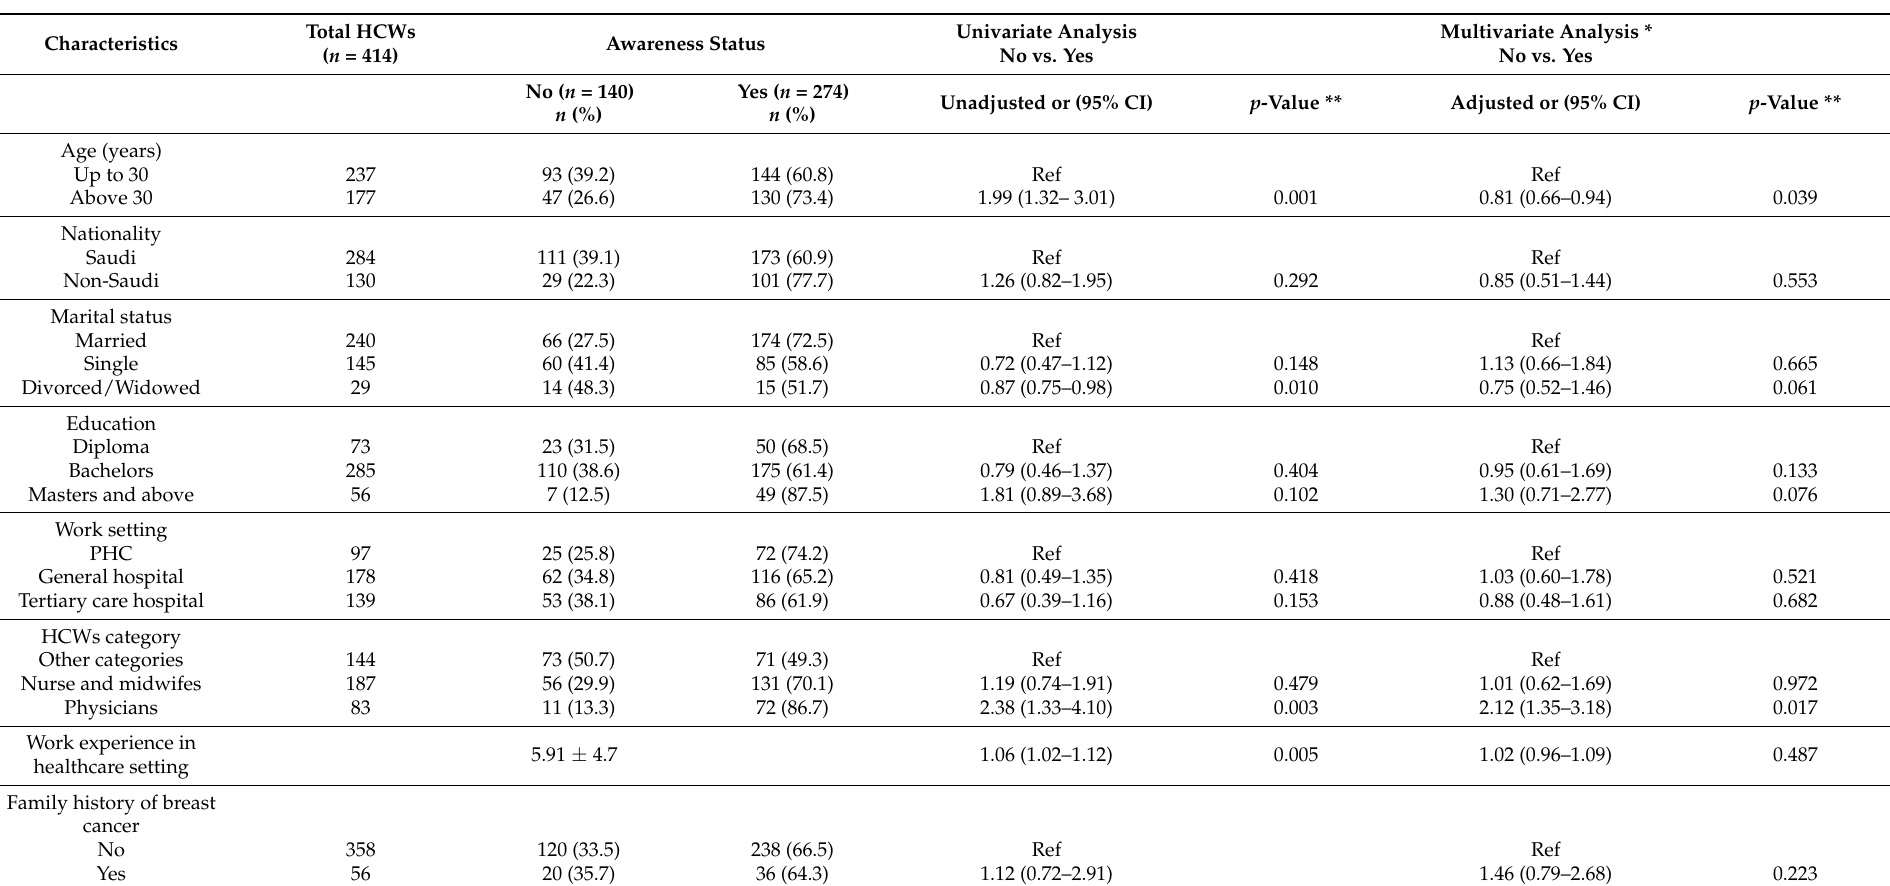
Table 7. Binomial regression analysis between participants’ socio-demographic characteristics and awareness on the MOH, Saudi Arabia’s recommendation for mammogram screening for breast cancer ( n =